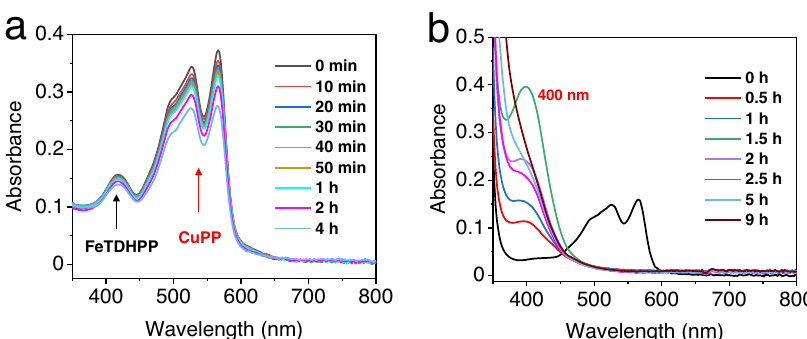
Fig. 7 UV – vis absorption spectra of systems. a In all, 0.01 mM CuPP, 0.5 µ M FeTDHPP, 0.1 mM BIH in a quartz cuvette (10-mm path length), and b 0.1 mM CuPP, 0.2 µ M FeTDHPP, and 100 mM BIH upon irradiation with white LED light. Solutions for ( b ) at different times were transferred and diluted fi ve times with DMF to a quartz cuvette (2-mm path length) under N 2 .